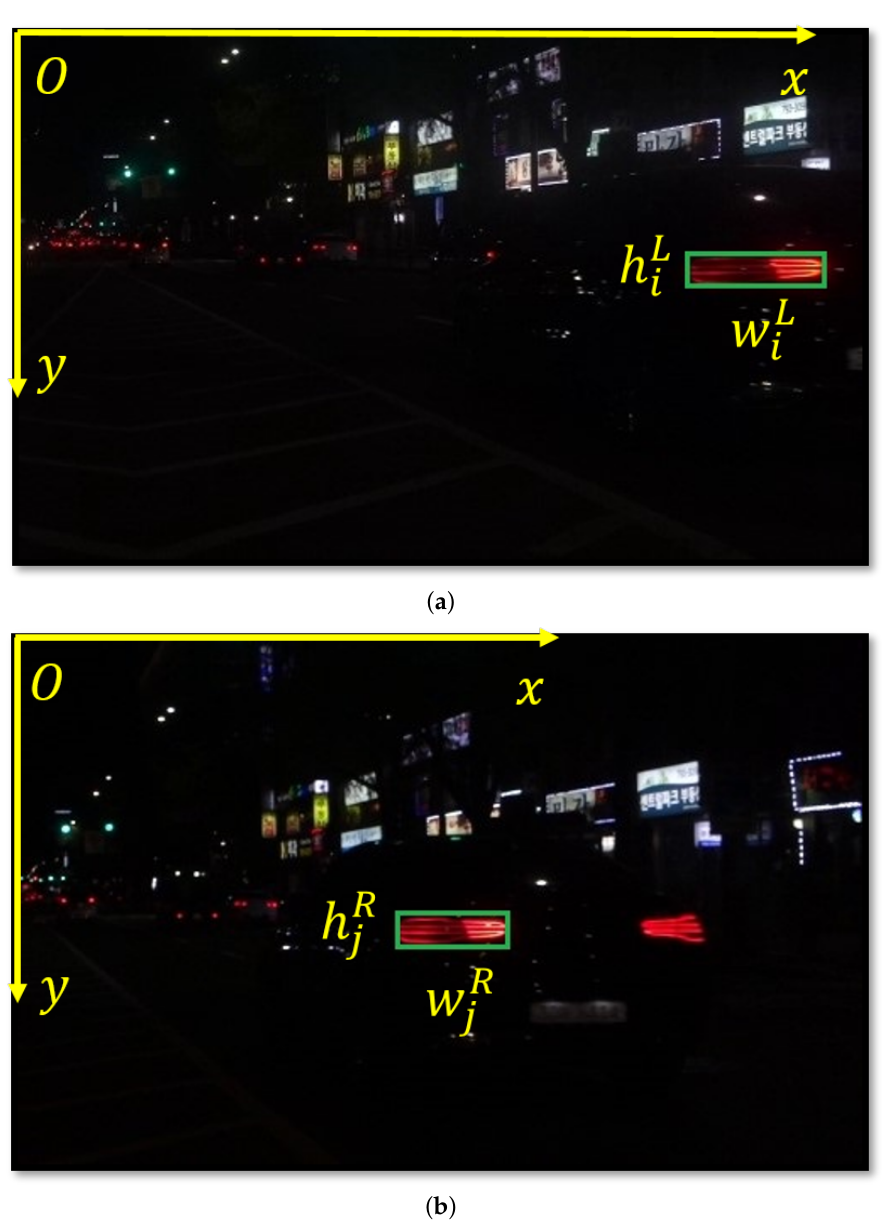
Figure 17. Width and height of the taillight in: ( a ) left image; ( b ) right